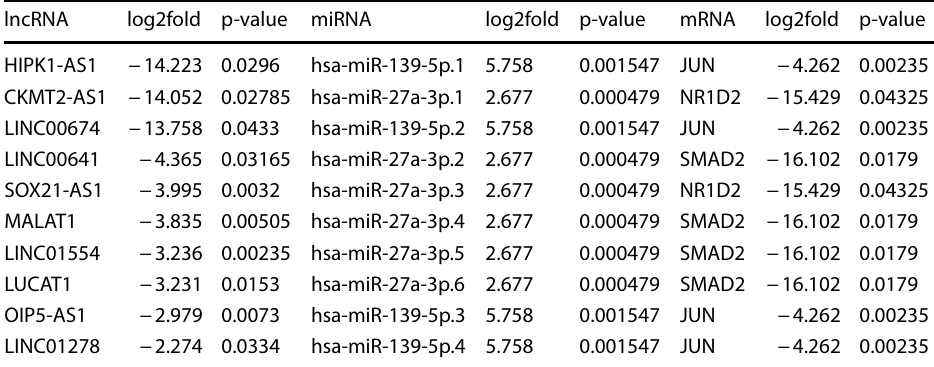
lncRNAs in OS-P compared to OS showing correlative expression with miRNAs and further mRNAs